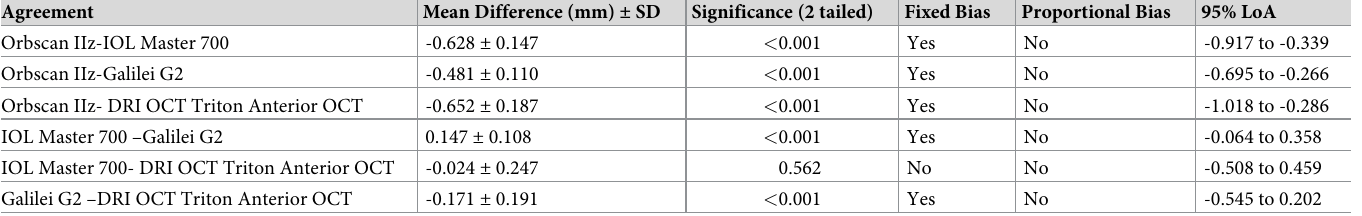
Table 2. Agreement of white-to-white/horizontal internal anterior chamber diameter between the Orbscan IIz, IOL Master 700, Galilei G2 and DRI OCT Triton Anterior OCT.